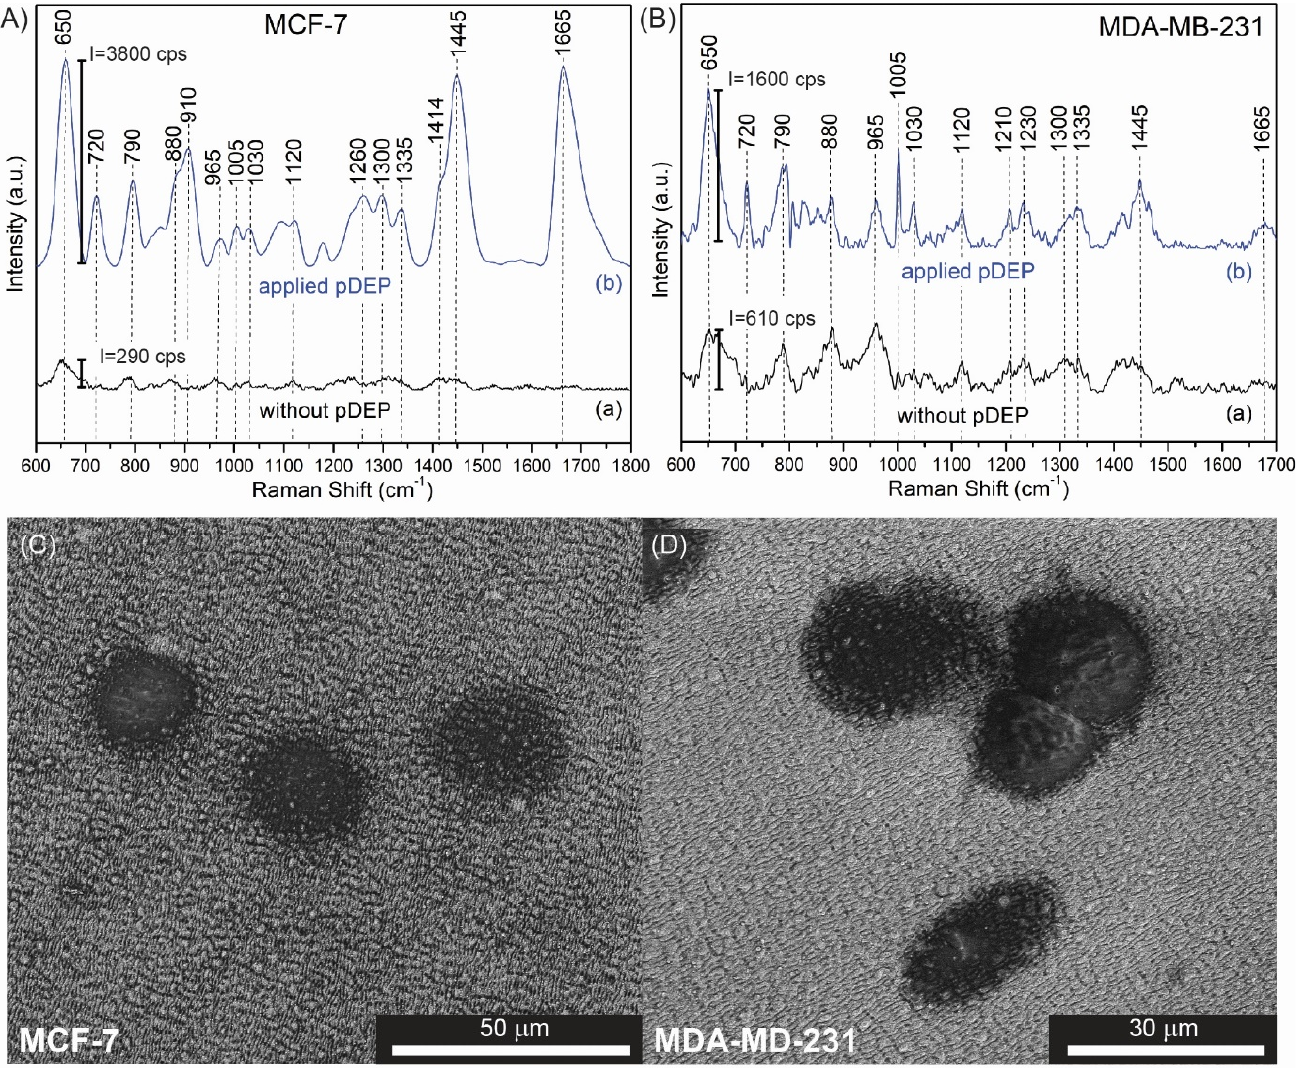
Figure 8. The SERS spectra of ( A ) MCF − 7 and ( B ) MDA − MD − 231 recorded in the pDEP − SERS device without (a) and with (b) the application of dielectrophoretic trapping of CTCs. The corre- sponding SEM images of ( C ) the MCF − 7 and ( D ) MDA − MD − 231 deposited on the surface of the SERS platform with this dielectrophoretic effect.